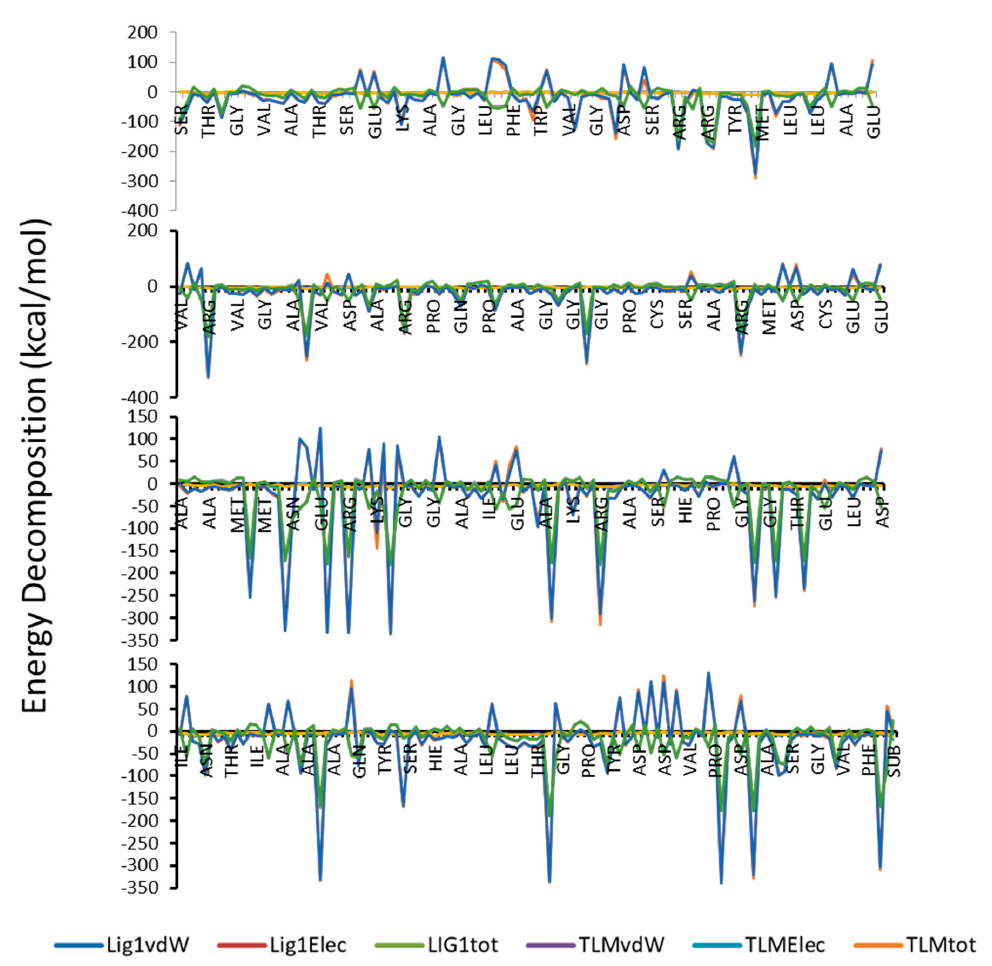
Figure 7. Total Energy decomposition, van der Waals and electrostatic energy (kcal / mol) for the complexes of compound 1 and TLM with